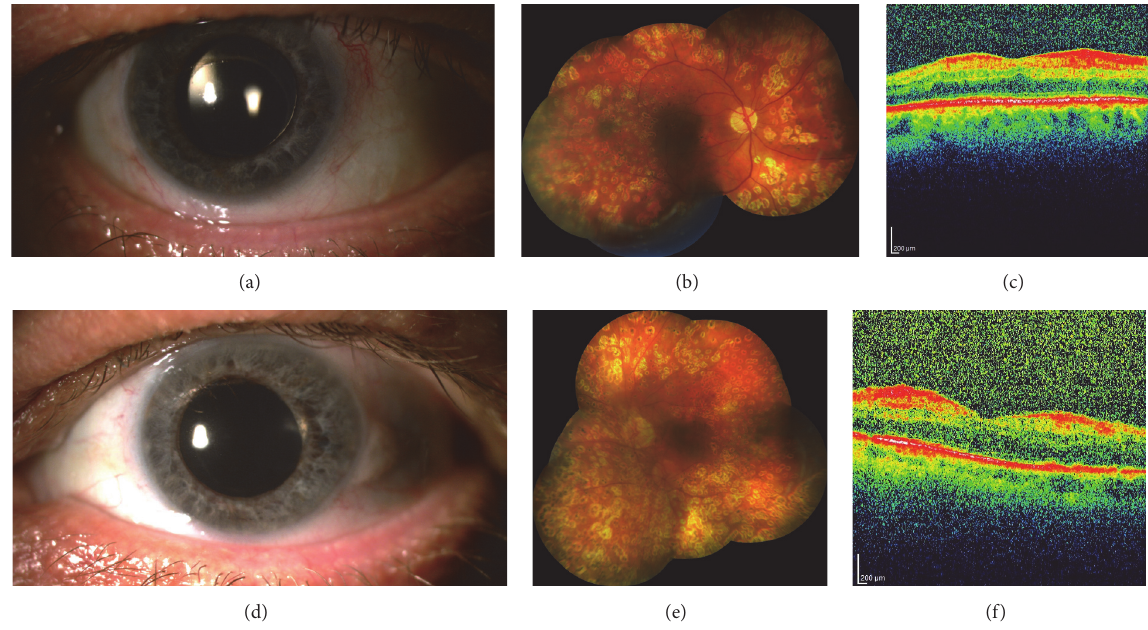
Figure 3: (a) Color anterior segment picture of the right eye with a quiet anterior segment and intraocular lens; (b) right composite fundus pictureshowing thelaserscars scattered 360 degrees and a normal-looking macula; (c) rightOCTscan depicting thenormal macular contour; (d) color anterior segment picture of the left eye with a quiet anterior segment and intraocular lens; (e) left composite color fundus picture demonstrating the 360 degrees’ scattered laser scars and a normal-looking macula; (f) left OCT scan depicting the normal macula.